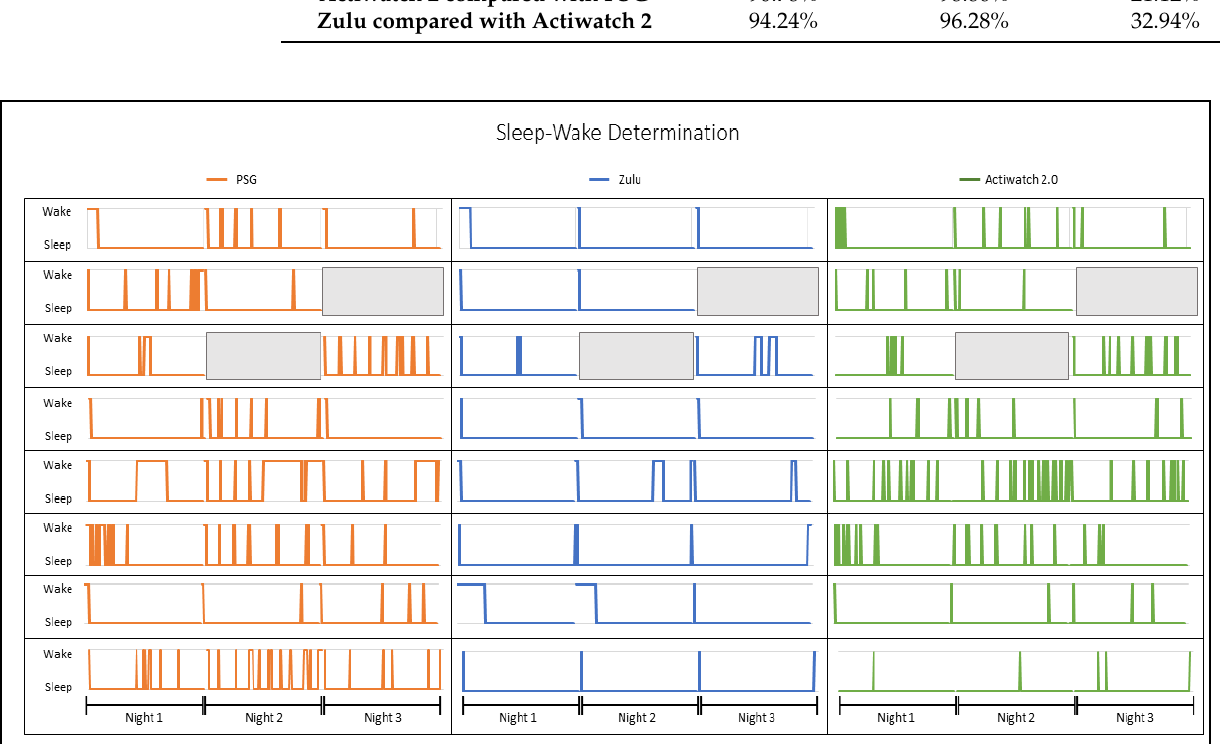
Figure 2. Comparison of the participants’ epoch-by-epoch sleep–wake hypnograms by polysomnography (PSG), Zulu watch, and actigraphy. A three-panel comparison of the PSG, Zulu watch, and Actiwatch 2 sleep–wake determination across all study nights by participant. Epochs are shown in study days and graphed along the x -axis. Sleep versus wake determination is plotted in orange ( ) for PSG, blue ( ) for the corresponding Zulu watch data, and green ( ) for the corresponding Actiwatch 2 data. Missing nights of data are indicated by gray blocks ( ).